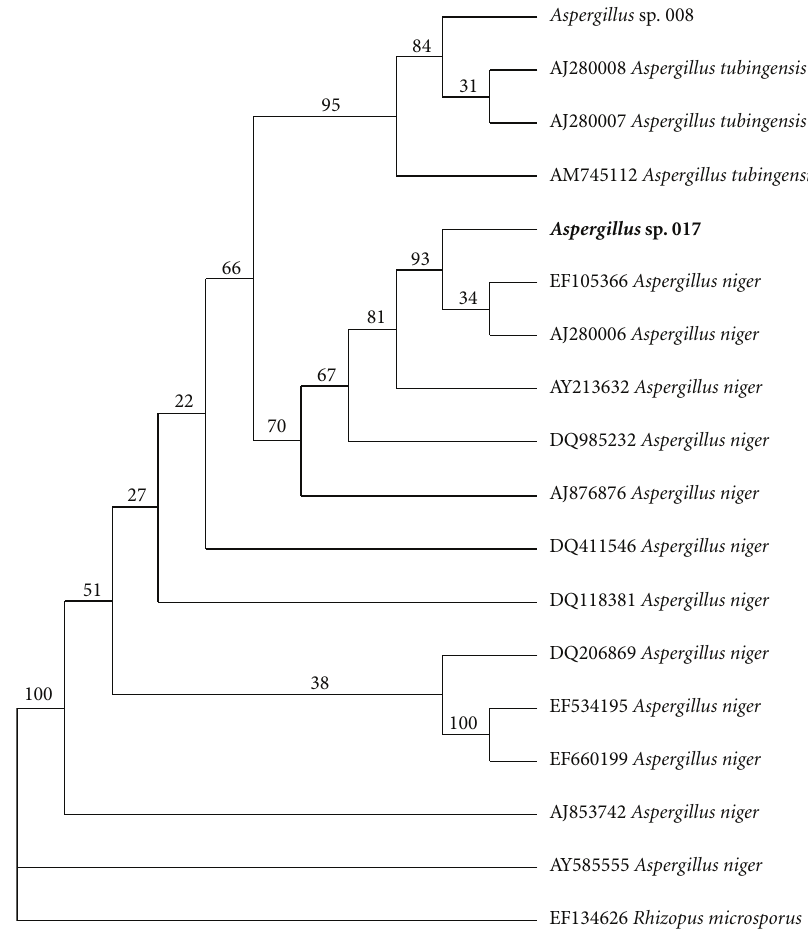
Figure 1: NJ trees calculated from ITS1-2, 5.8S rDNA sequence. Rhizopus microsporus was used as outgroup taxa. The internal topology of Aspergillus sp. 017 was grouped to Aspergillus niger (EF105366 and AJ280006) with the 93% supportive bootstrap